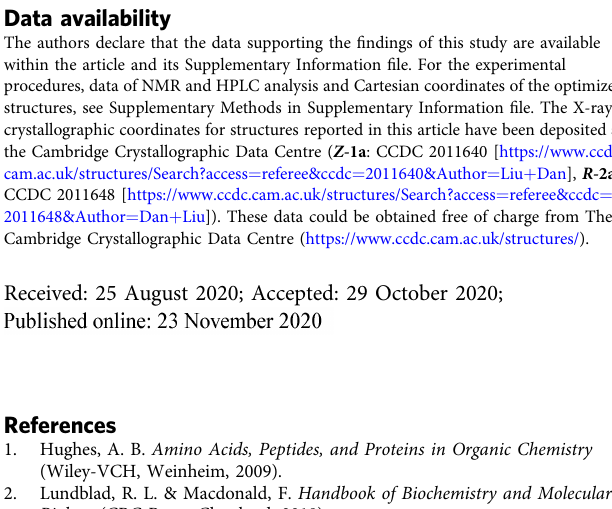
molecules including drug intermediates and chiral ligand. A